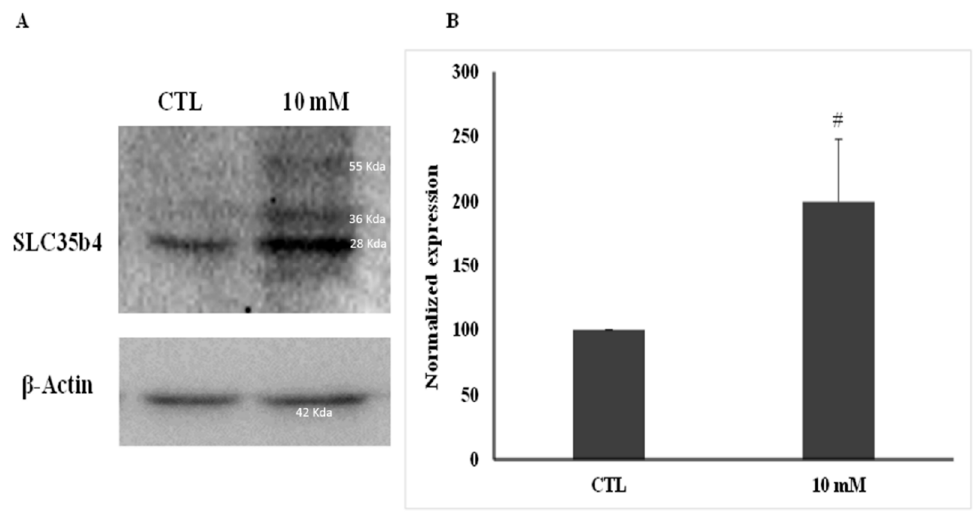
Figure 2. SLC35B4 protein level upon glucose stimulation. ( A ) SLC35B4 protein expression by Western blot analysis in HepG2 cells treated with 10 mM glucose for 24 h. β -Actin was used as an internal control. The above blot has been cropped. The full length blots are available in the supplementary material ( B ) The quantification of SLC35B4 levels is represented as percent increase or decrease compared to control levels and was evaluated in four independent experiments. The results were presented as the mean ± standard error of the mean (SEM). # corresponds to p < 0.005 versus the control group . Control (CTL).